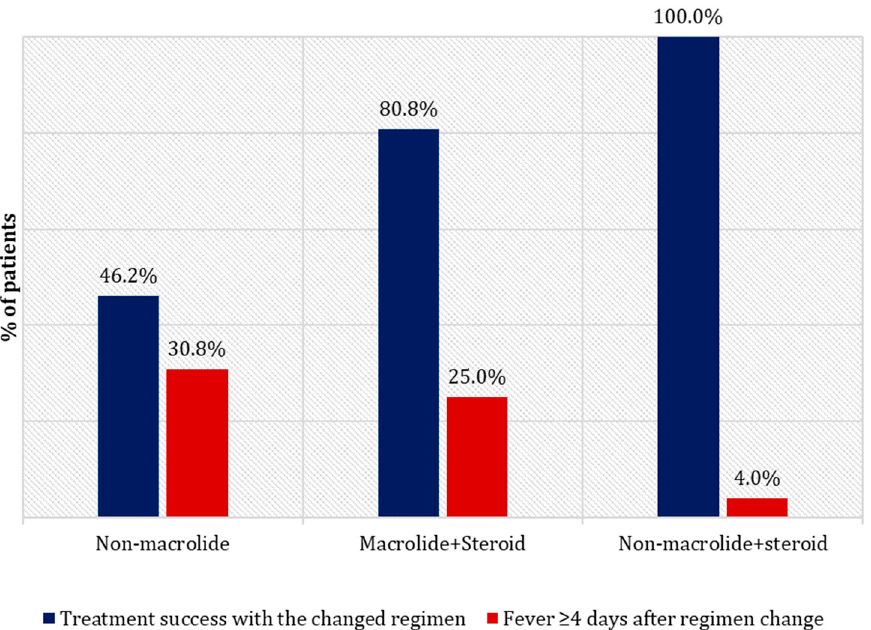
Figure 2. Comparison of the percentage of patients with treatment success versus fever duration of 4 days or more after regimen change. The treatment success rates of the regimens were as follows: non-macrolide, 46.2%; macrolide + steroid, 80.8%; non-macrolide + steroid, 100.0%. The percentage of patients with a fever duration of ≥ 4 days was highest in the non-macrolide group (30.8%) and lowest in the non-macrolide + steroid group (4.0%).